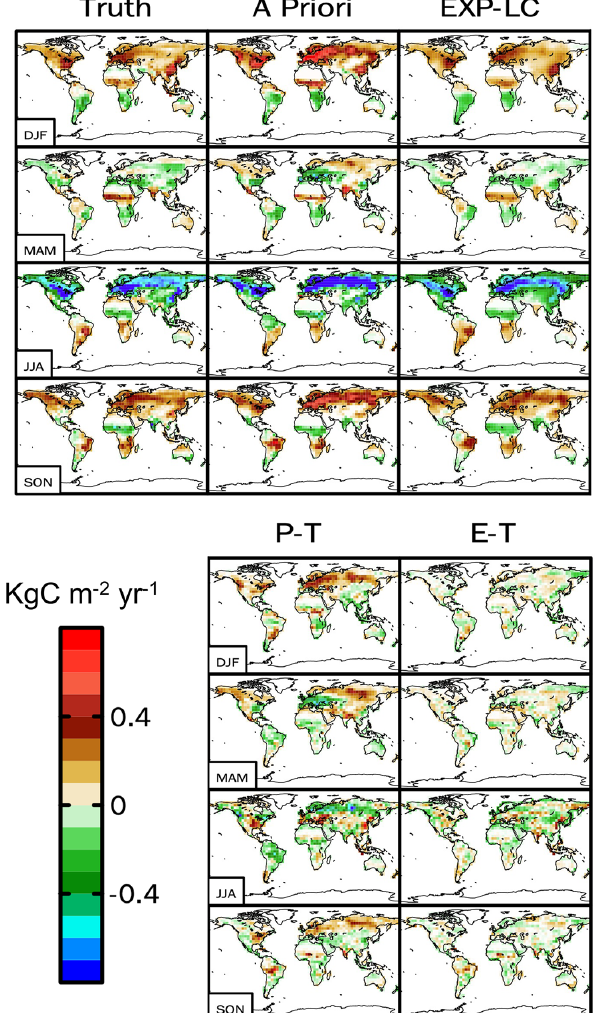
does not degrade the overall performance at the seasonal and